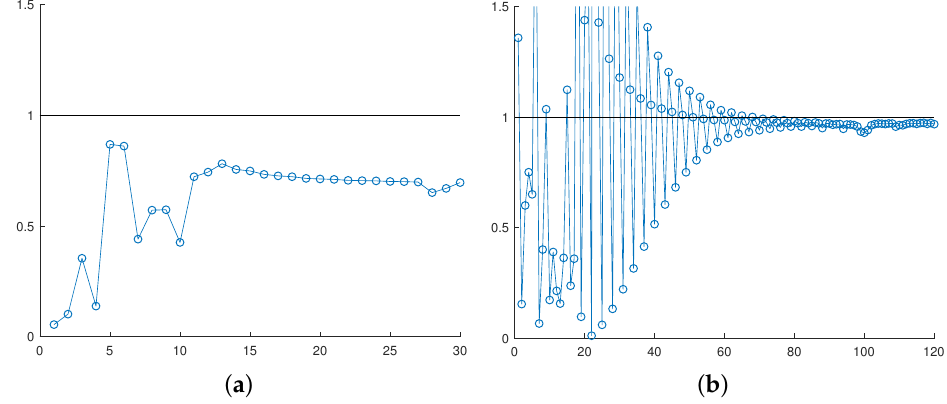
Figure 18. ( a ) Convergence rate for the Schwarz iterations: R = 1300, Γ = 3.495; ( b ) convergence rate for the Schwarz iterations: R = 5000, Γ =